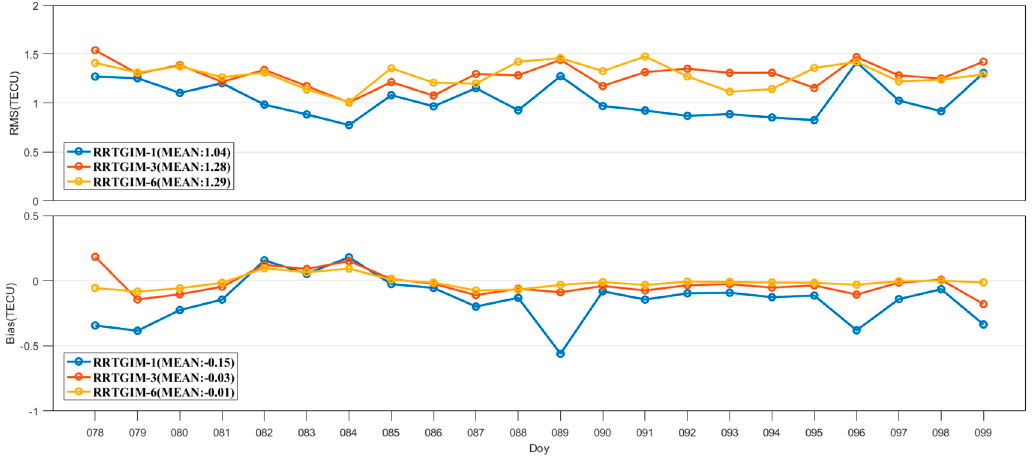
Figure 10. Root mean square (RMS) of modeling VTEC residuals from DOY 78 to 99, 2020, of RRTGIM-1, RRTGIM-3, and RRTGIM-6.